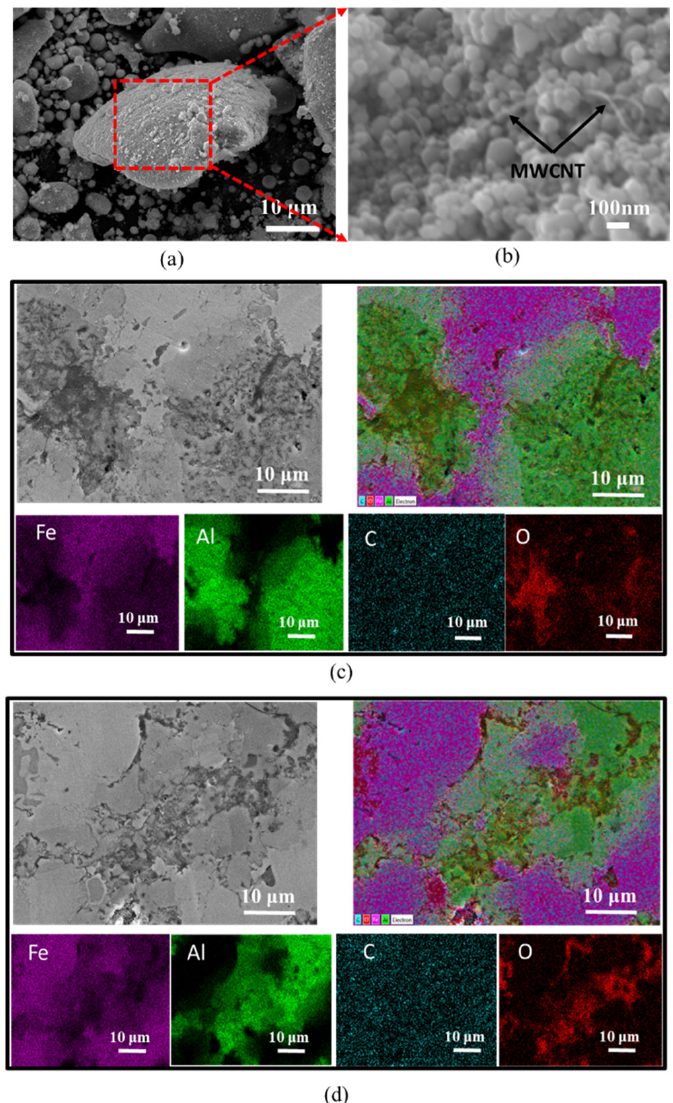
Figure 12. Morphology of the composites with the mixture of Fe nanoparticles and Fe microparticles: ( a ) SEM image of 40nFe-40mFe-19Al-1MWCNT powders after 24 h of ball milling; ( b ) high magnification ( × 50,000) of the selected region in ( a ); ( c ) EDS mapping of 40nFe-40mFe-19Al-1MWCNT nanocomposites and ( d ) EDS mapping of 20nFe-60mFe-19Al-1MWCNT nanocomposites .